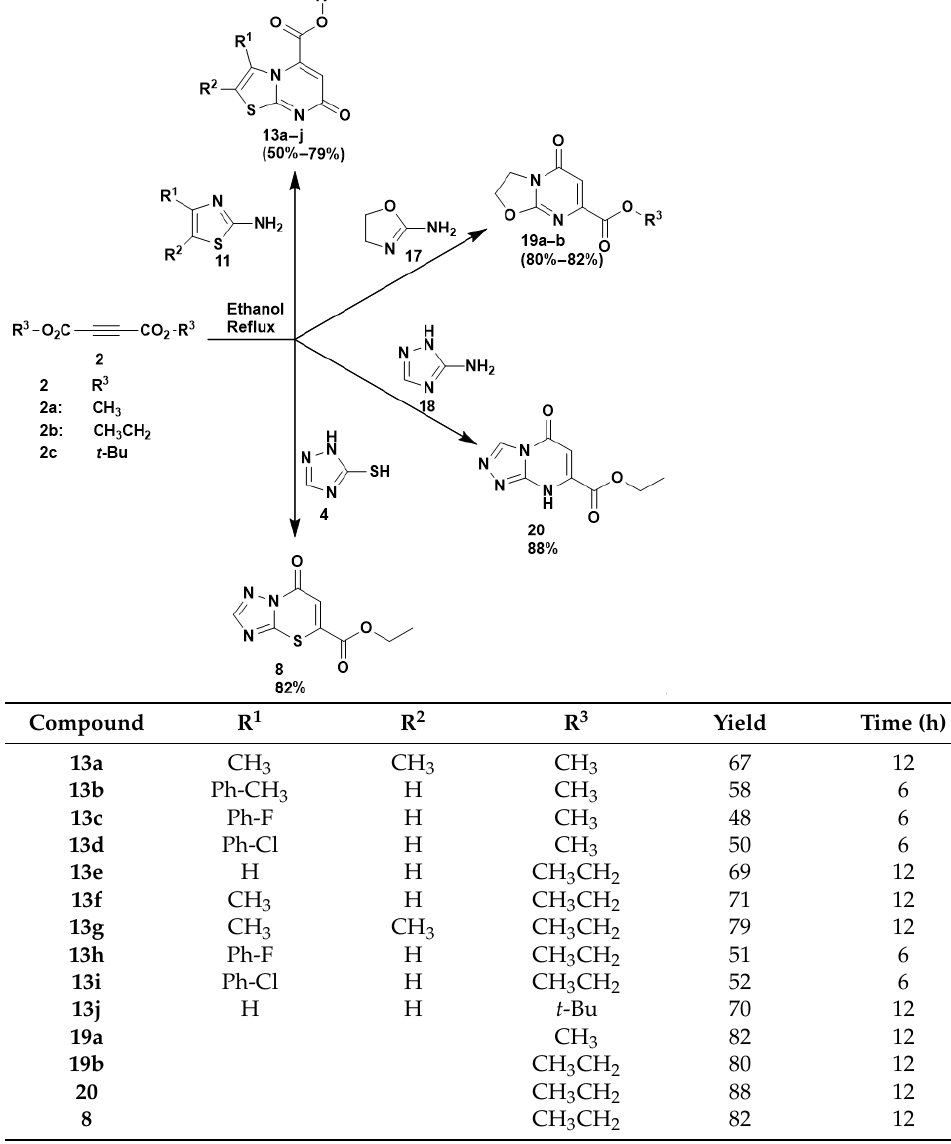
Table 2. Isolated yields and reaction times for preparation of 8 , 13a–j, 19a–b and 20 .